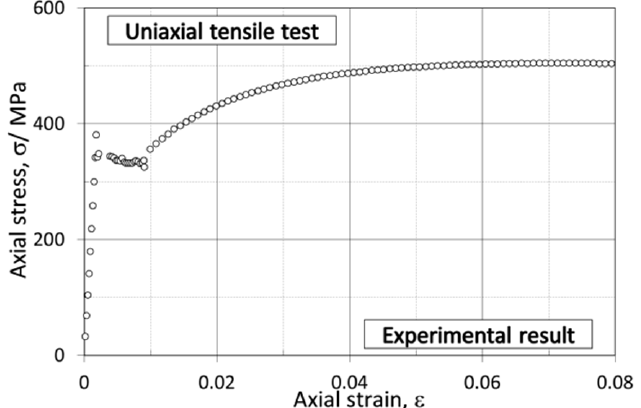
Figure 4. Experimental monotonic tensile stress–strain curve. Table 2. Mechanical properties of averaged material obtained by monotonic tensile tests.